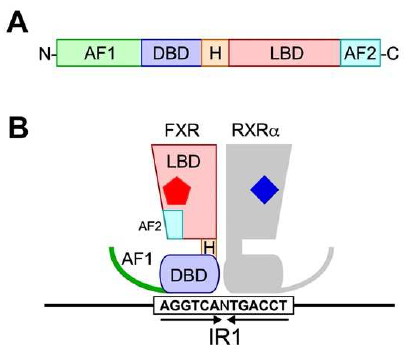
Figure 3. Protein structure of FXR. ( A ) General structure of nuclear receptors. A typical nuclear receptor consists of functional domains, such as activation of function 1 domain (AF1), DNA-binding domain (DBD), hinge region (H), ligand-binding domain (LBD), and activation of function 2 domain (AF-2). ( B ) Schematic representation of ligand-FXR-RXR α complex bound to IR1 element. Arrows indicate the inverted repeats of FXRE. Red pentagon and blue rhombus represent a bile acid molecule and an RXR α agonist, such as 9-cis-retinoic acid,